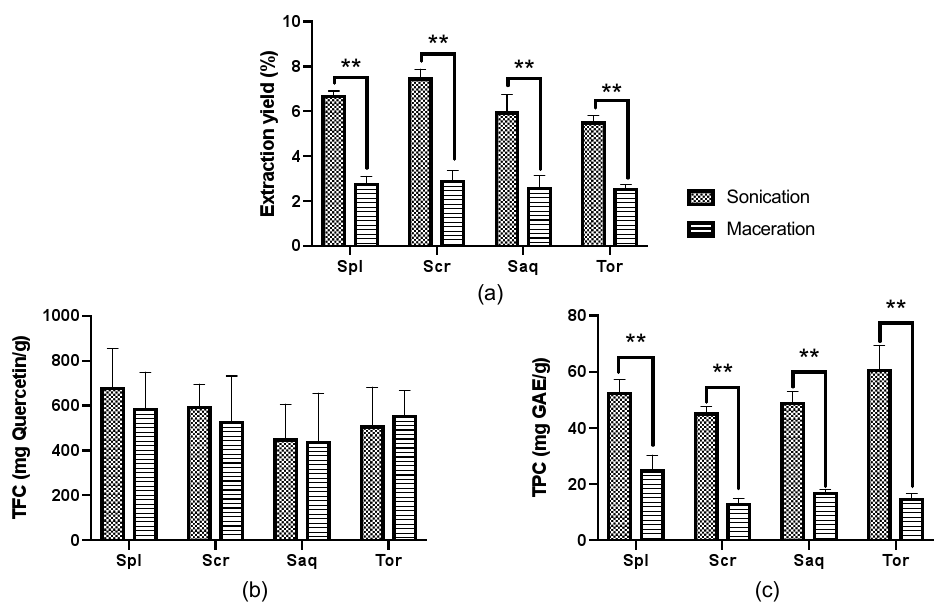
Figure 2. ( a ) Extraction yield, ( b ) Total flavonoid contents (TFC), and ( c ) Total phenolic contents (TPC) from four brown algae; Sargassum polycystum (Spl), Sargassum cristaefolium (Scr), Sargassum aquifolium (Saq) and Turbinaria ornata (Tor), extracted with two different extraction techniques, namely cold maceration and sonication, or ultrasonic-assisted extraction (UAE). Data are represented as mean ± SD, and the statistical difference in bioactive compounds for each brown algae are represented as ** p ≤ 0.01.